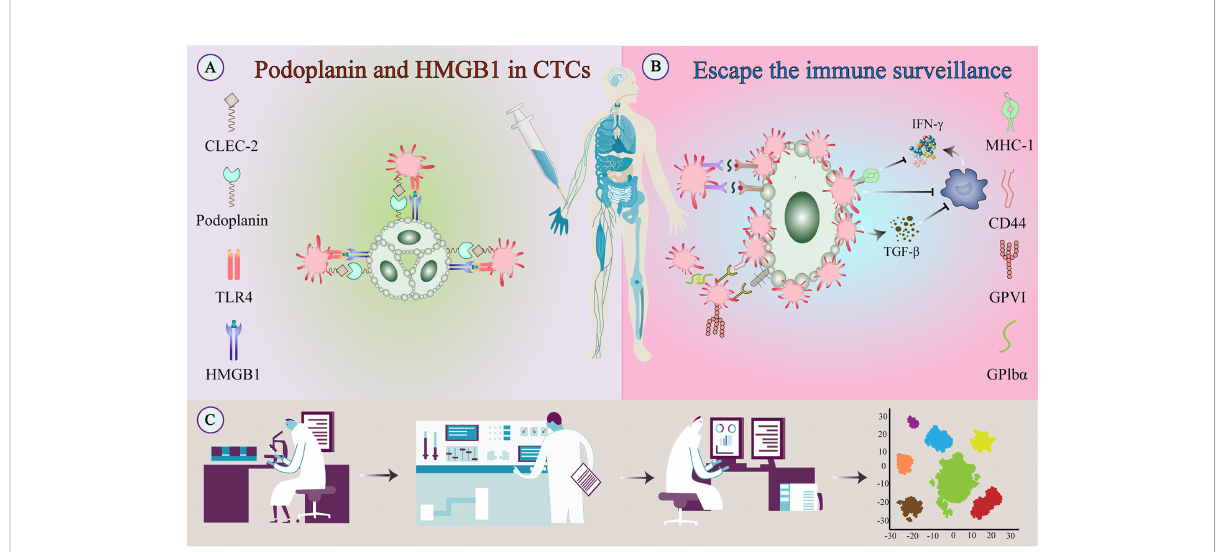
FIGURE 4 Escape of tumor cells from immune surveillance. (A) Platelets bind to tumor-derived HMGB1 via TLR4 and interact with podoplanin-expressing tumor cells via CLEC2 to stimulate their activation. (B) Activated platelets and fi brinogen can form a protective barrier against the mechanical forces of blood fl ow and also against NK cell attack. In addition to providing physical shielding, platelets can protect CTCs from circulating NK cell-mediated tumor lytic activity and can interfere with tumor cell recognition by NK cells. (C) TEPs as a noninvasive biomarker source for cancer detection and progression monitoring. The examination of TEPs mainly includes ultra-deep, massively parallel, and long-read sequencing of TEP transcripts and possible detection of epigenetic transcriptional signatures. Improving the sensitivity and accuracy of detection techniques and the speci fi c selection of tumor-affected platelets can improve diagnostic accuracy and treatment prediction. CLEC-2, C-type lectin-like receptor-2; CTC, circulating tumor cell; HMGB1, high-mobility group box 1; NK cell, natural killer cell; TEPs, Tumor-educated platelets; TLR, toll-like